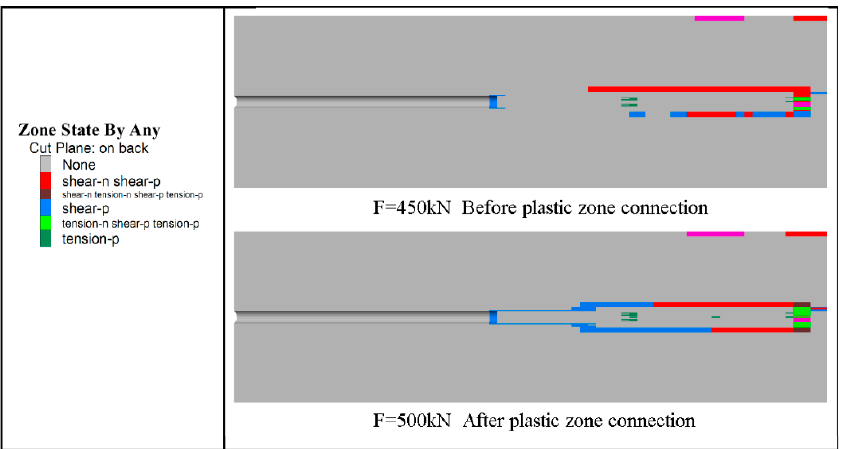
Figure 9. Before and after the plastic zone of the anchor cable is connected.